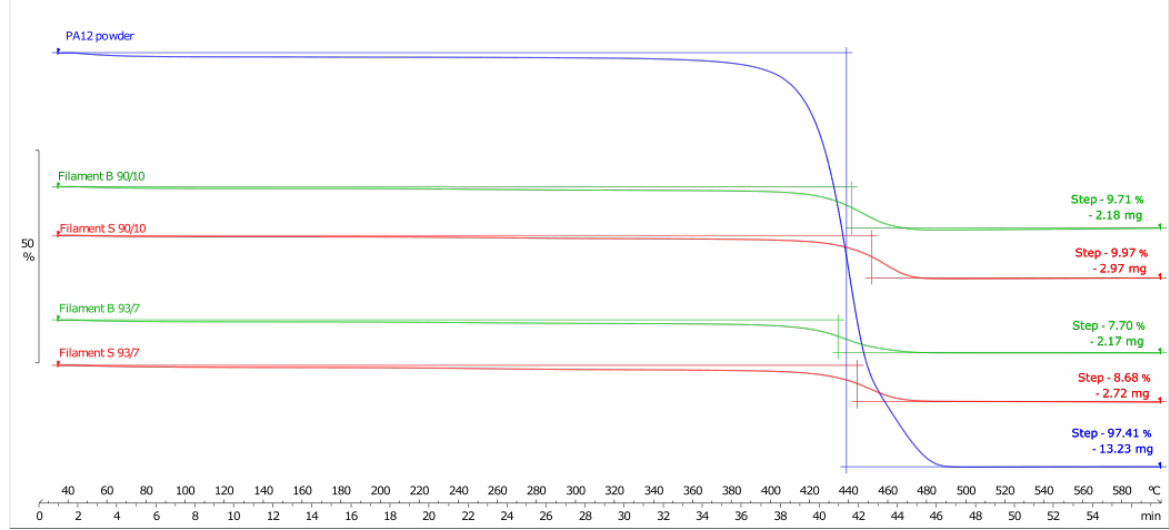
Figure 5. TGA curves after heating the filaments to 600 °C.